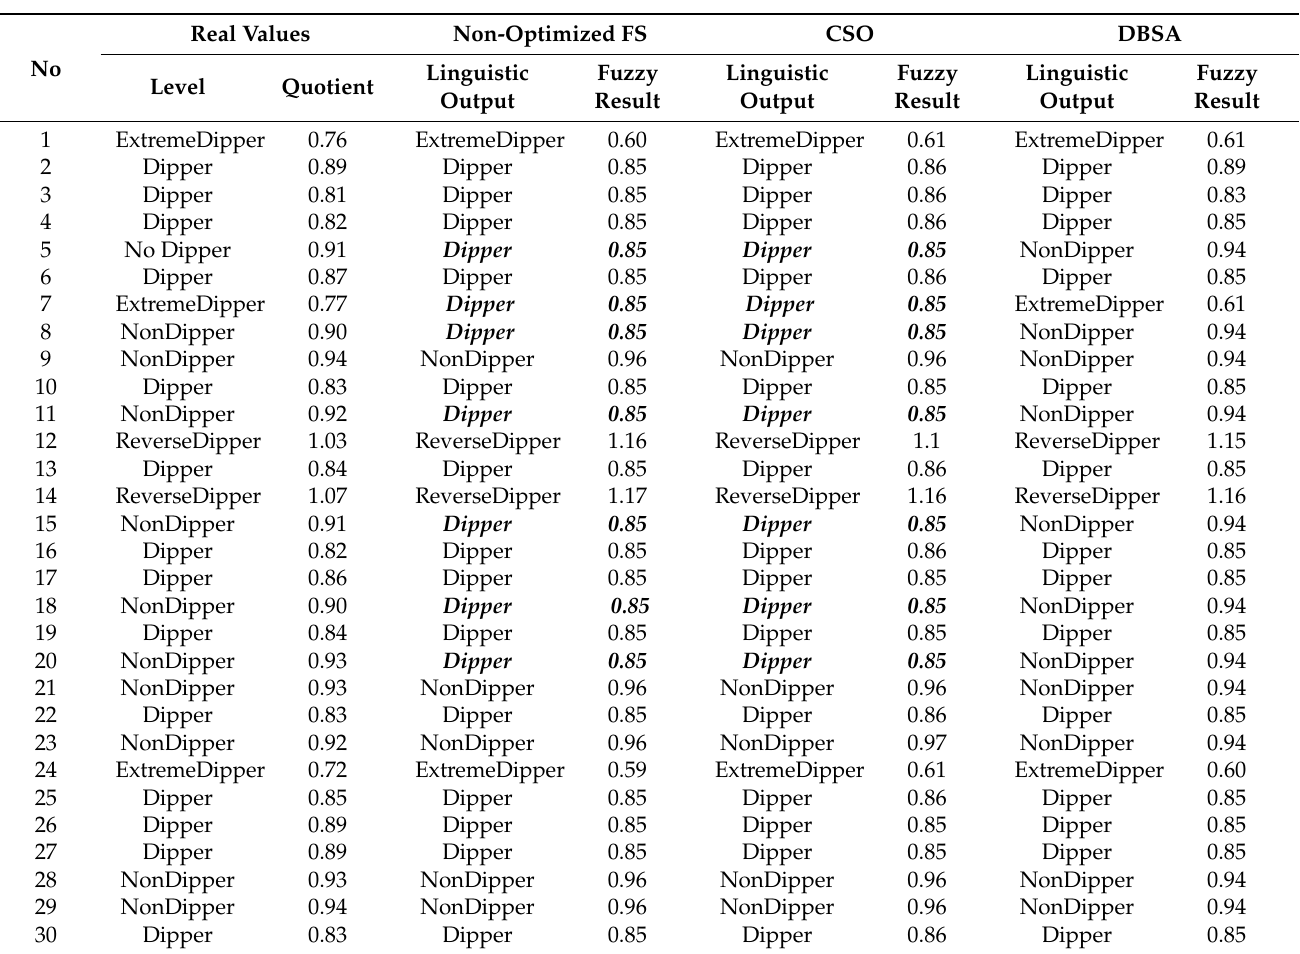
Table 8. Comparative of the results provided for the nocturnal blood pressure profile optimized using trapezoidal membership functions.